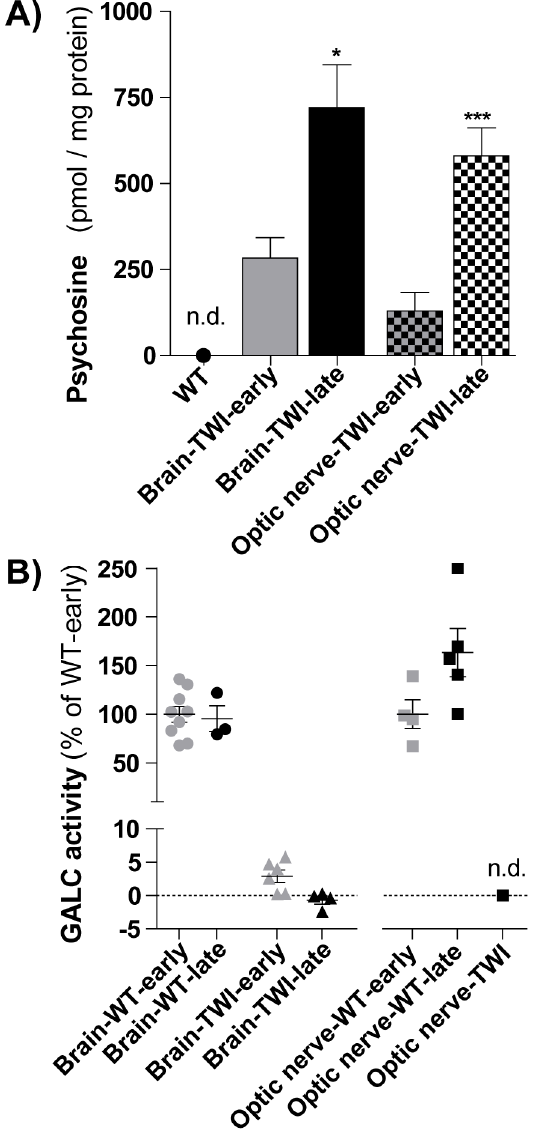
Figure 3. ( A ) Psychosine (PSY) quantification. PSY content was measured in brains (full-filled color columns) and optic nerves (squared columns) of TWI mice in the early stage of disease (early: PND20-28, n = 7) and in the late stage of the disease (late: PND30-38, n = 12 for brain and n = 8 for optic nerve). */*** p < 0.05/0.001 early vs. late, Student’s t -test. PSY was not detectable (n.d.) in WT mice, in both districts. Data = mean ± SEM. ( B ) Galactosylceramidase (GALC) quantification. GALC activity (reported in percentage in respect to the respective WT-early) was measured in brains (left; circles and triangles) and optic nerves (right; squares) of WT and TWI mice in the early stage of disease (early, in grey: PND20-21 for brains, PDN18 for optic nerves) and in the late stage of the disease (late, in black: PND30-38). GALC was not detectable (n.d.) in the optic nerves of TWI mice. Each point represents a mouse; data= mean ±